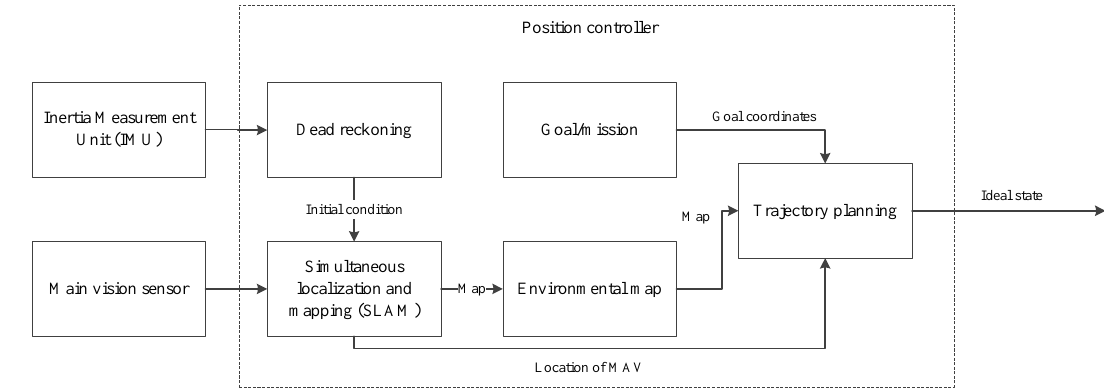
Figure 3. Functional blocks of the position